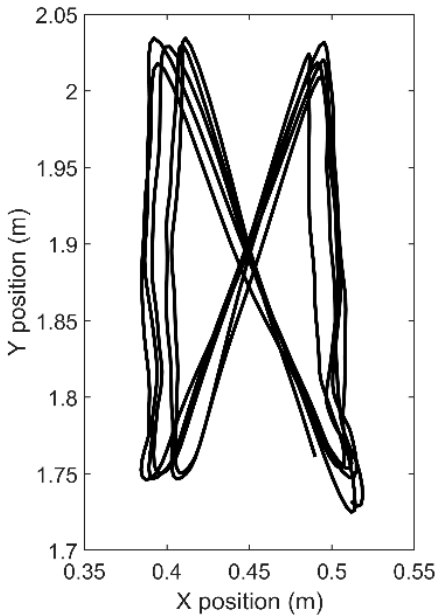
Figure 1. Center-of-pressure trajectory of walking. Five consecutive strides (gait cycles) recorded by the instrumented treadmill are shown. The raw 500 Hz signal was low-pass filtered at 30 Hz and down-sampled at 50 Hz. The X position corresponds to the movements perpendicular to the direction of progression. The Y position corresponds to the movements parallel to the direction of progression.